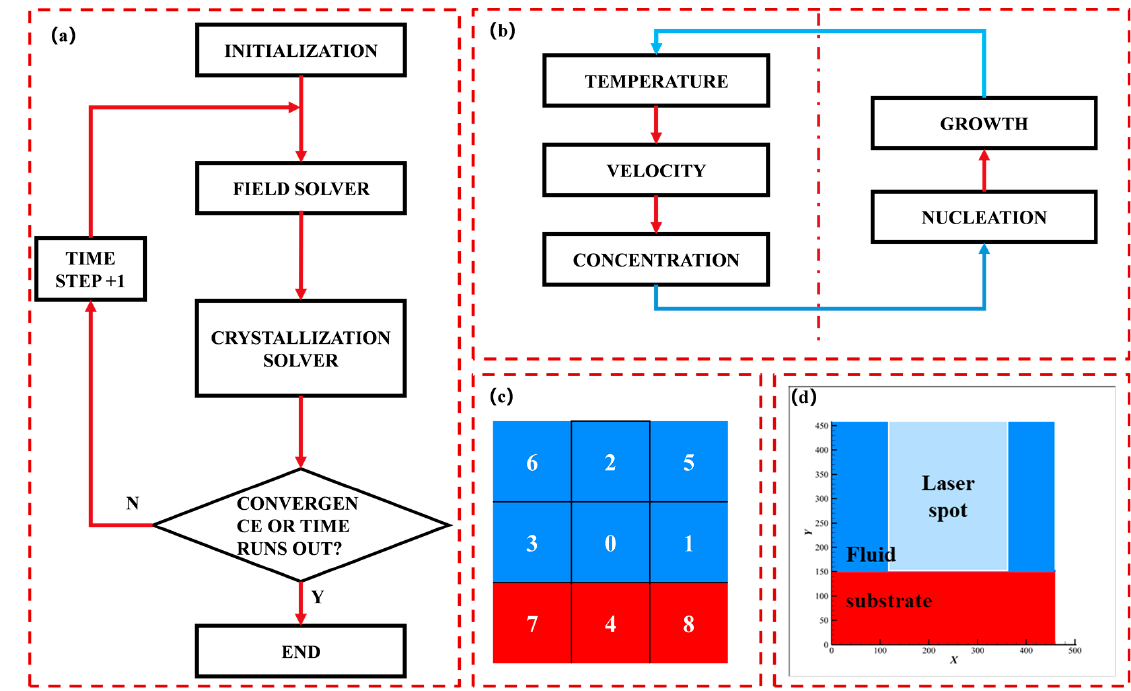
Figure 2. Calculation framework and model. ( a ) Flowchart of calculation program; ( b ) Internal logical relationship between field solver and crystallization solver; ( c ) Schematic diagram of the computational lattice at the fluid–solid interface; ( d ) Schematic diagram of computational domain.